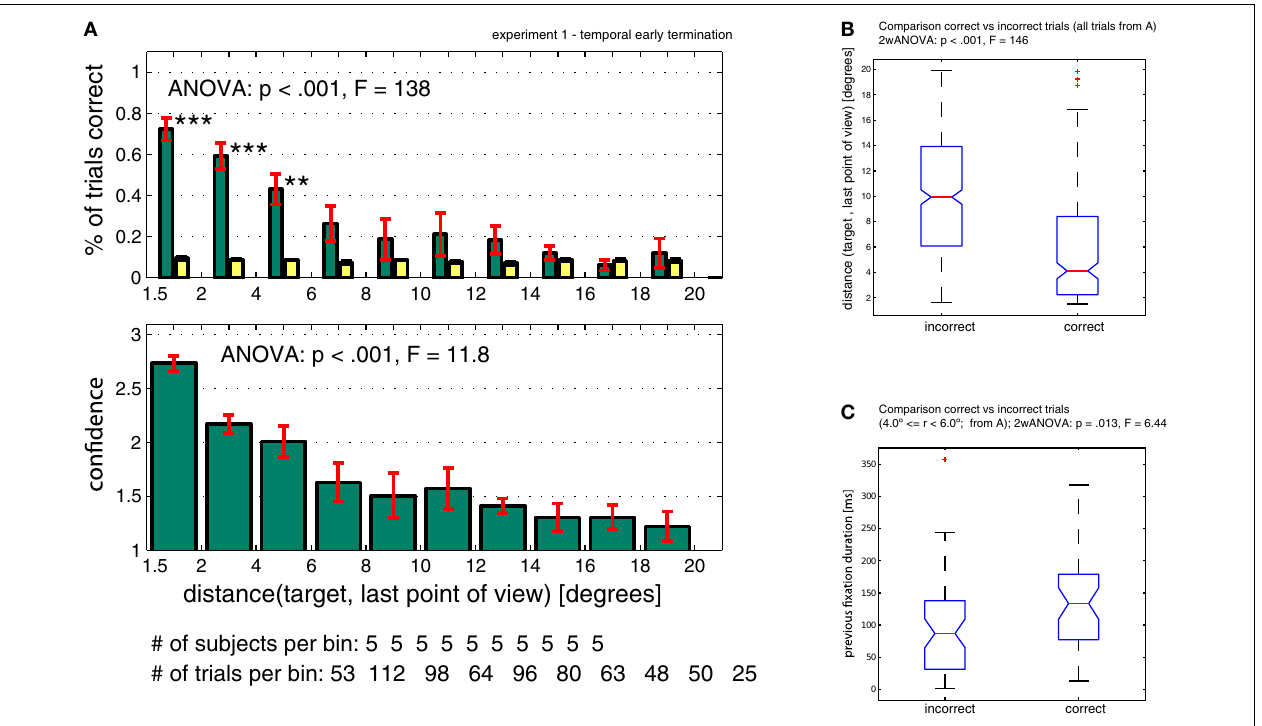
FIGURE 5 | Performance when trials were randomly terminated throughout a trial (temporal early termination, Experiment 1). (A) Subjects’ performance and confi dence depends on the distance between target and the last point of view. Bin size is 2º, however the fi rst bin only includes 1.5–2.0º (since < 1.5º is defi ned as the target). (B) Comparison of correct versus incorrect trials taken from (A) . Correct trials terminated closer to the target as incorrect trials